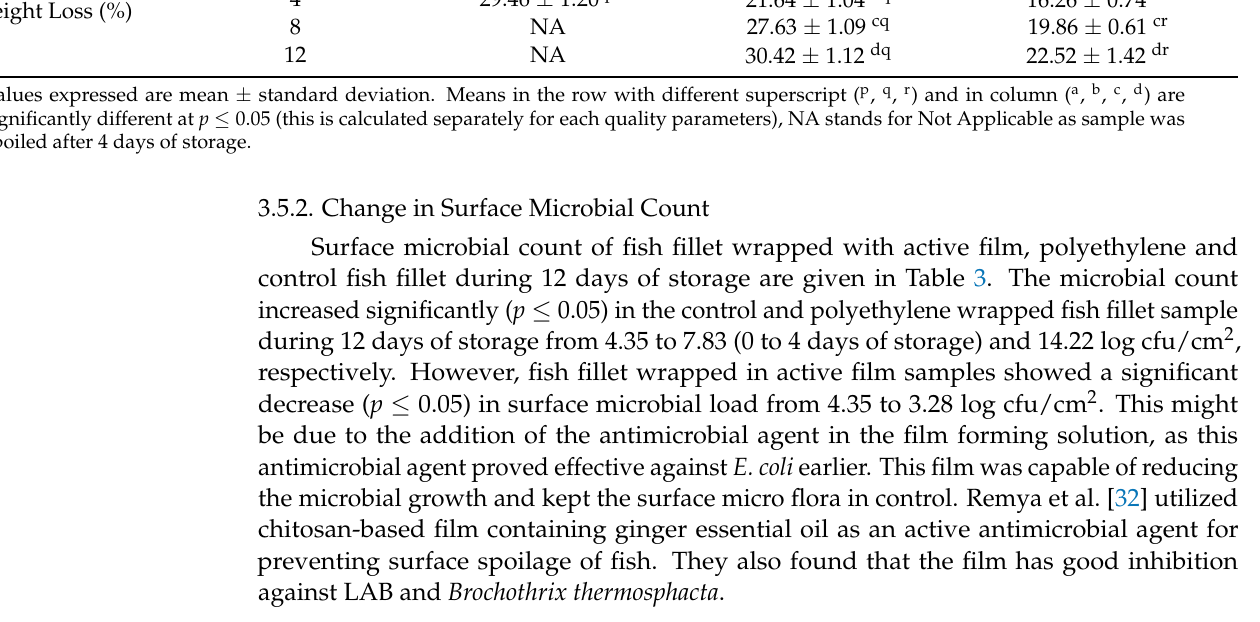
Table 3. Change in surface microbial count of fish fillet quality during storage. Fish Fillets